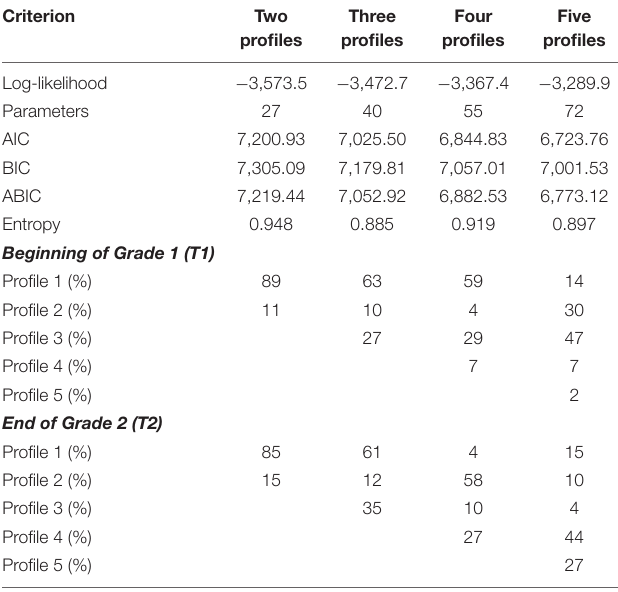
TABLE 4 | Fit indices for latent transition analysis for 2–5 latent profiles at the end of Grade